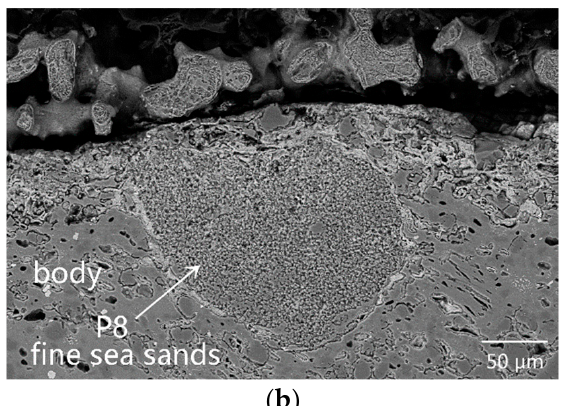
the box of ( b ), and ( d ) element mapping image of ( c ).